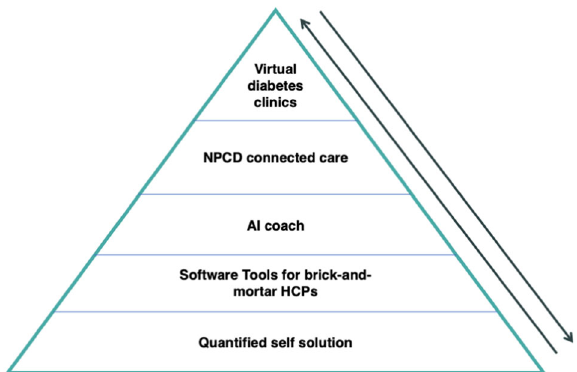
Fig. 1 Theoretical risk strati fi cation pyramid showing how the different categories of connected diabetes care could be deployed to improve population health. People can be guided to escalate and de-escalate among the different categories based on clinical need and individual